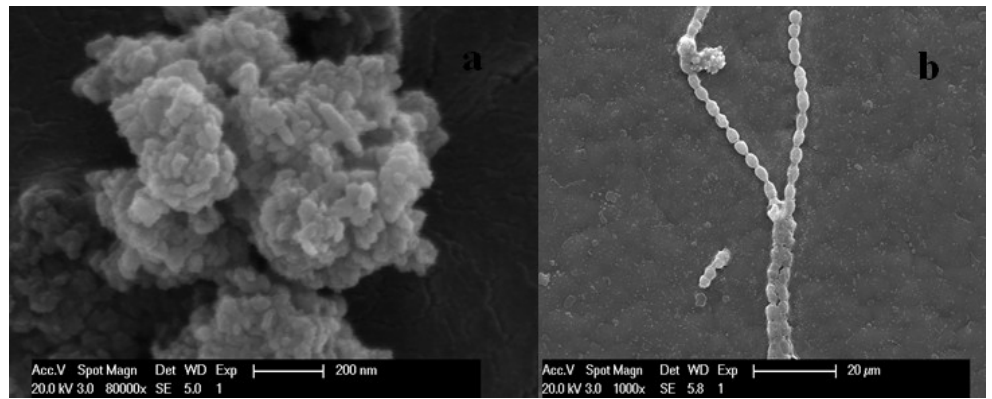
; ( b ) algae in the presence of 1.0 mg/L nano-TiO 2